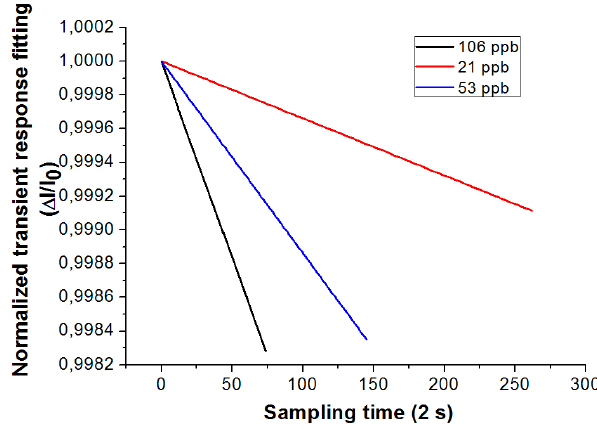
Figure 8. The normalized sensor response rate to the increasing concentration of vapor elemental mercury. Table 1. Linear fitting parameters of 10min sensor responses to 21ppb ≤ [Hg 0 ] ≤ 106ppb.